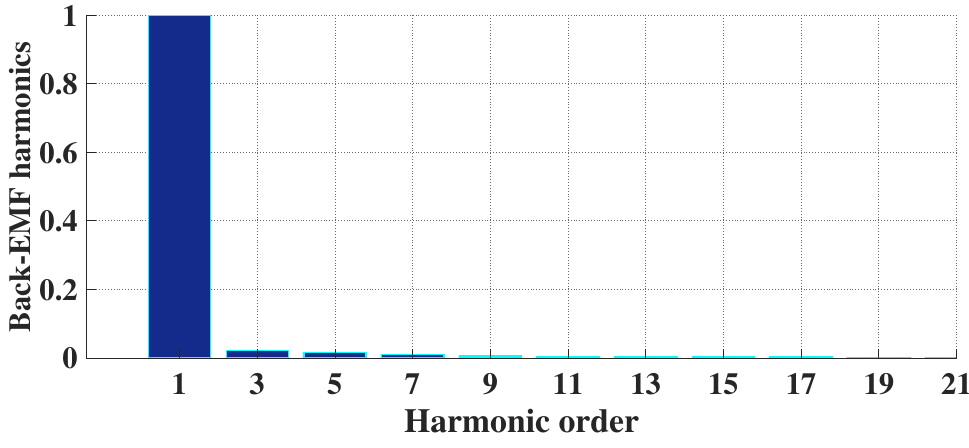
Figure 17. Back-EMF harmonic